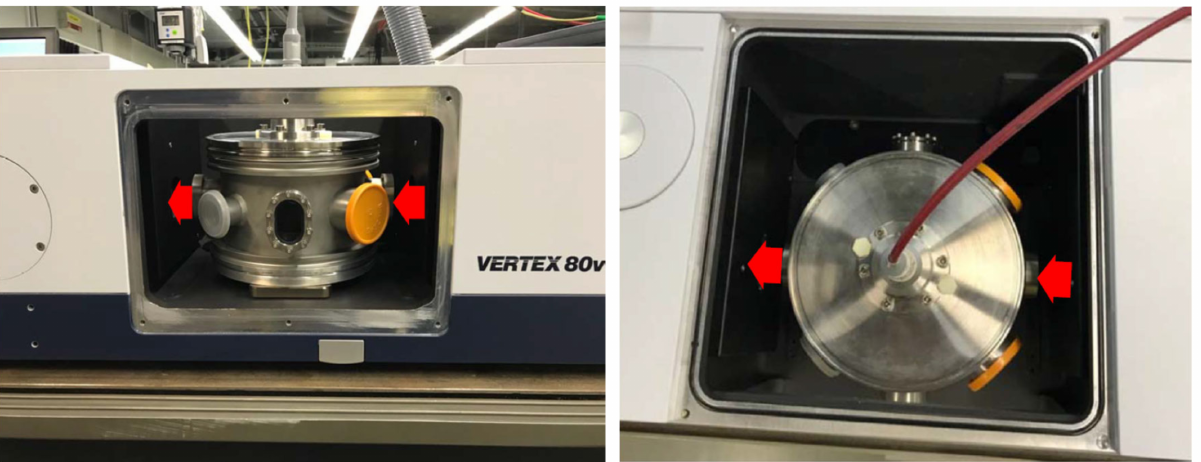
Figure 7. Side and top view photographs of the plasma reactor (see also Figure 4a) inside the sample compartment of the FTIR spectrometer, for in situ single-pass absorption measurements. The infrared passage through KBr windows is marked by the red arrows. The Faraday cage design of the reactor and its coaxial power supply cable protects against any possible electromagnetic perturbation to the FTIR